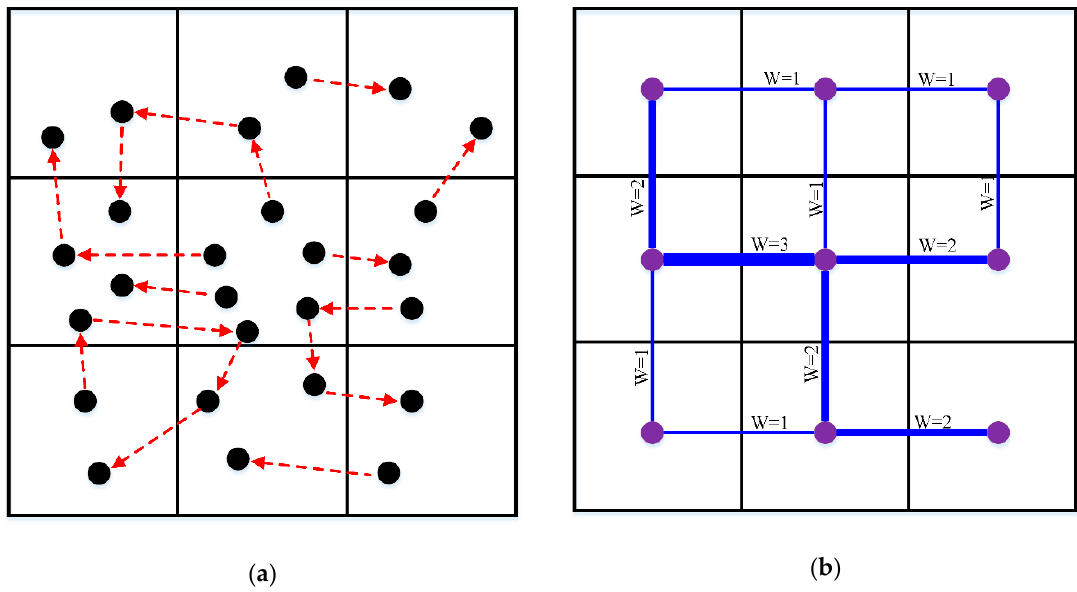
Figure 1. Example of the traffic flow and network: ( a ) taxi trajectory data, ( b ) flow network with edge weight equal to corresponding probabilities of movement between sub-regions.